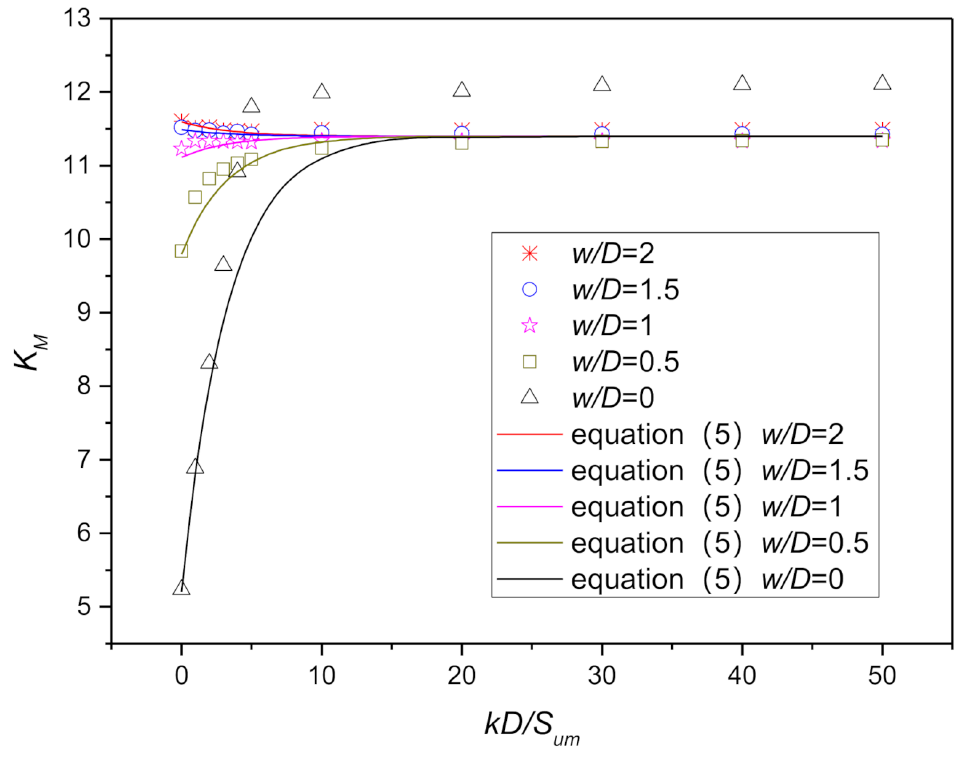
Figure 15. Moment dimensionless elastic stiffness coefficients with complete backflow of